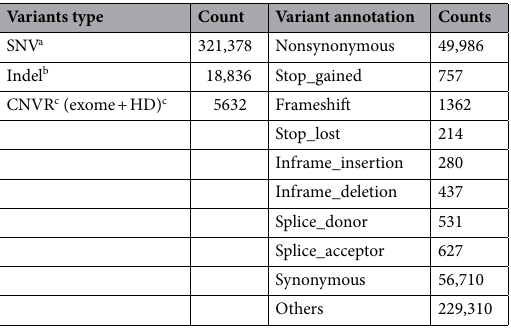
Table 3. Variant types and annotations from exome sequencing data of 517 sires. a SNV indicates single- nucleotide variant. b An insertion and a deletion affecting two or more nucleotides. c CNVR indicates copy number variation region.